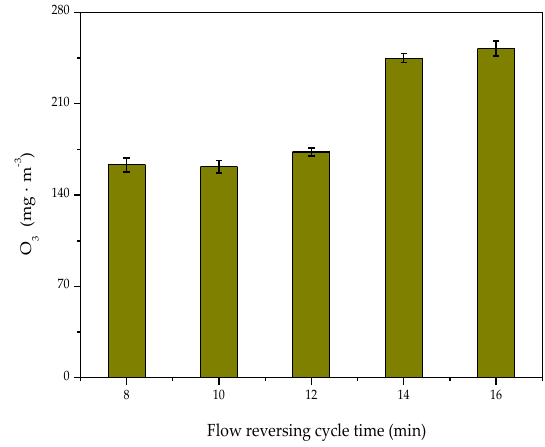
ff ect of flow reversing cycle time on O Figure 5. Effect of flow reversing cycle time on O 3 concentration. Figure 5. E